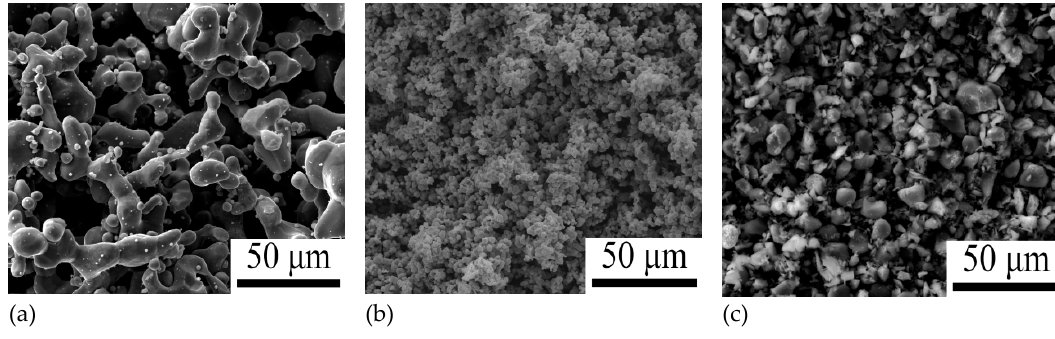
Figure 1. SEM images of ( a ) Ti, ( b ) Mo, and ( c ) TiB 2 powders. Cylindrical Ti-15Mo/TiB TMC specimens measured 15 mm in height and 19 mm in diameter